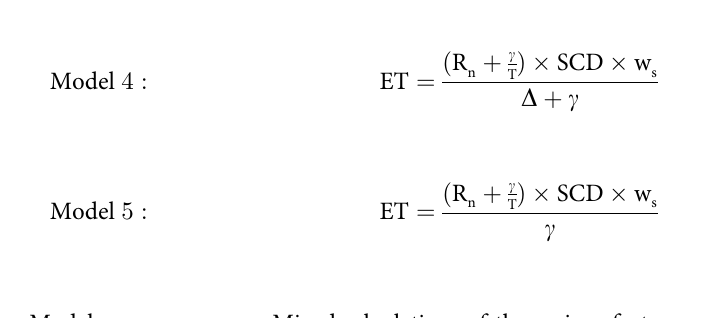
Model . . . : Mixed calculations of the various factors